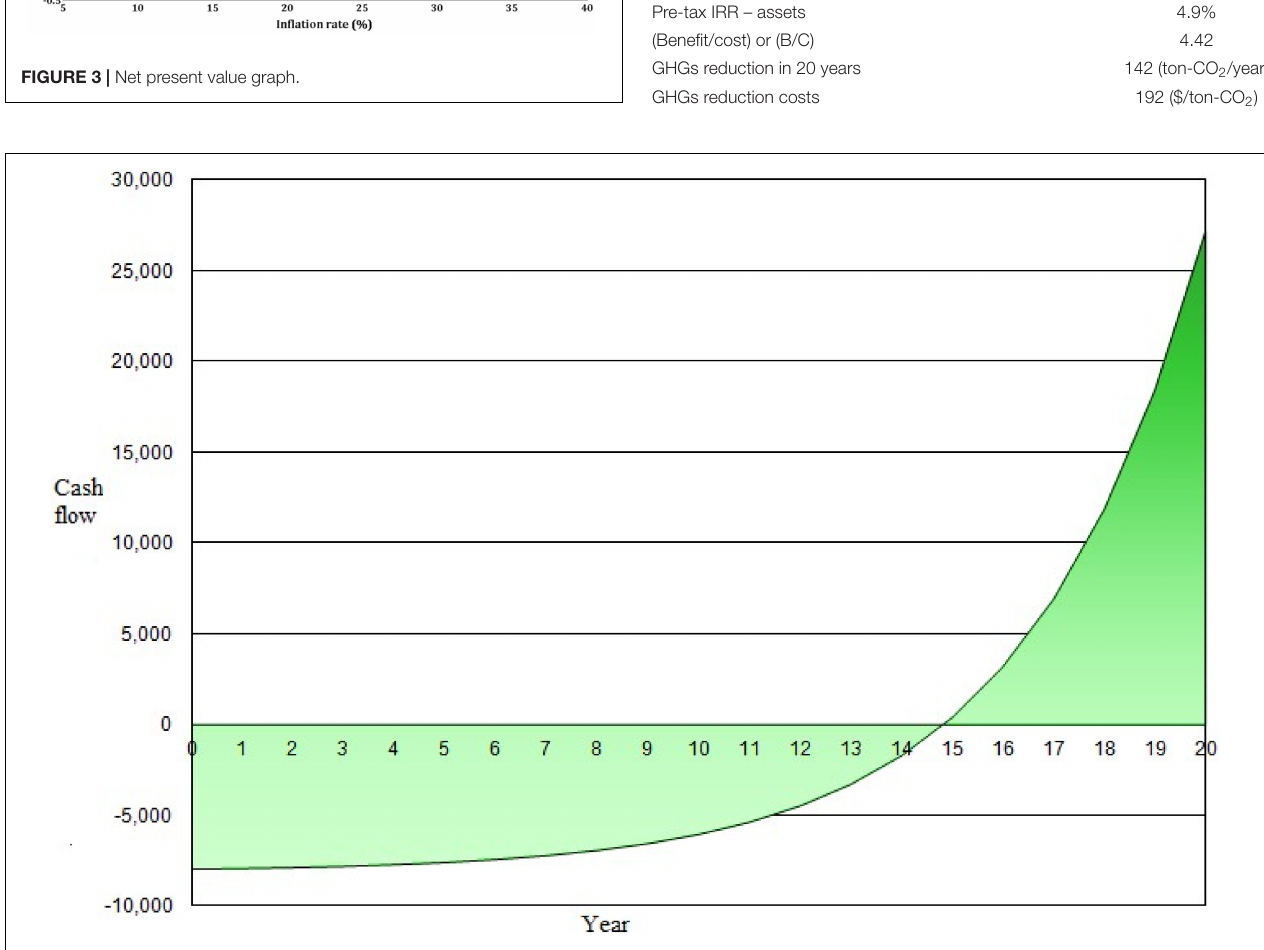
FIGURE 4 | Cash flow